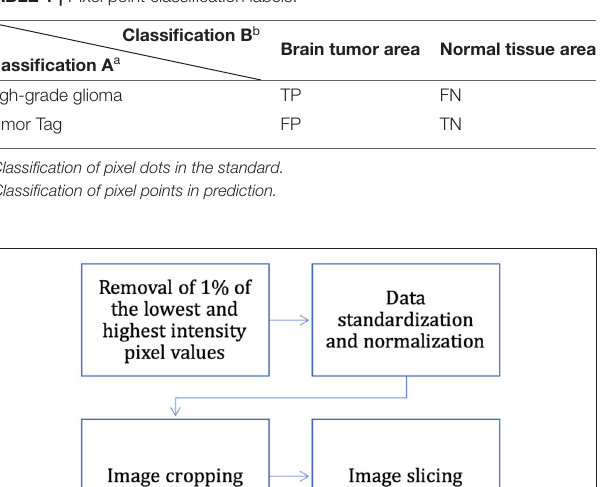
TABLE 1 | Pixel point classification labels.